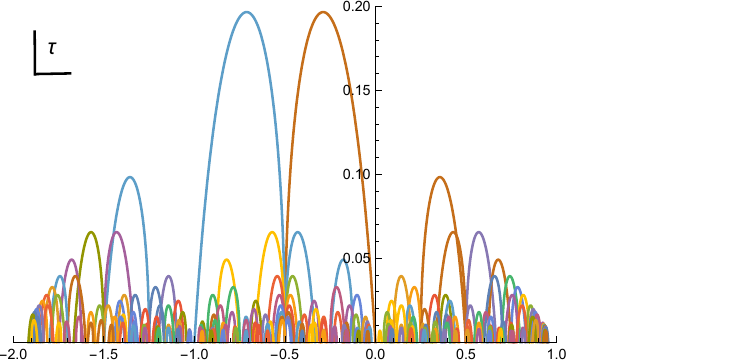
along the corresponding N 2 from the left m